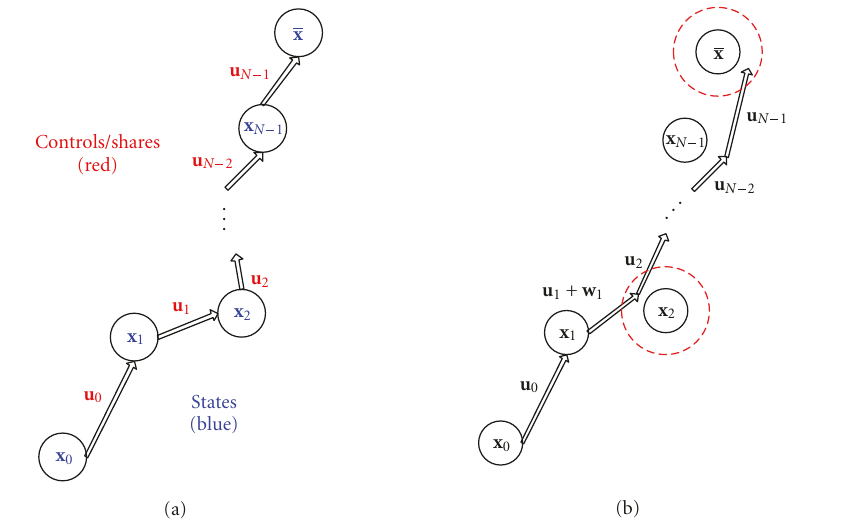
Figure 3: (a) Initial state being driven to the desired representative state x by node controls; (b) noisy control/share causes o ff set in trajectory which stays within some